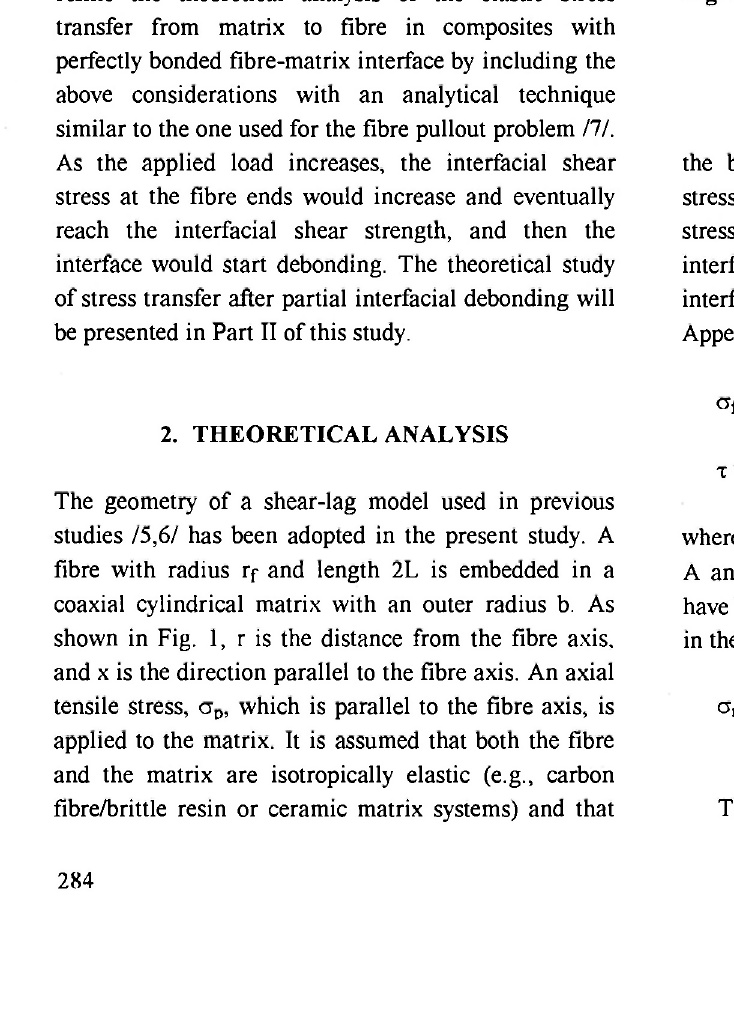
°P Fig. 1: Schematic drawing showing the idealized shear-lag model used in the present study to analyze the elastic stresses in fibre-reinforced composites. the bonded fibre-matrix interface (at r=rf)